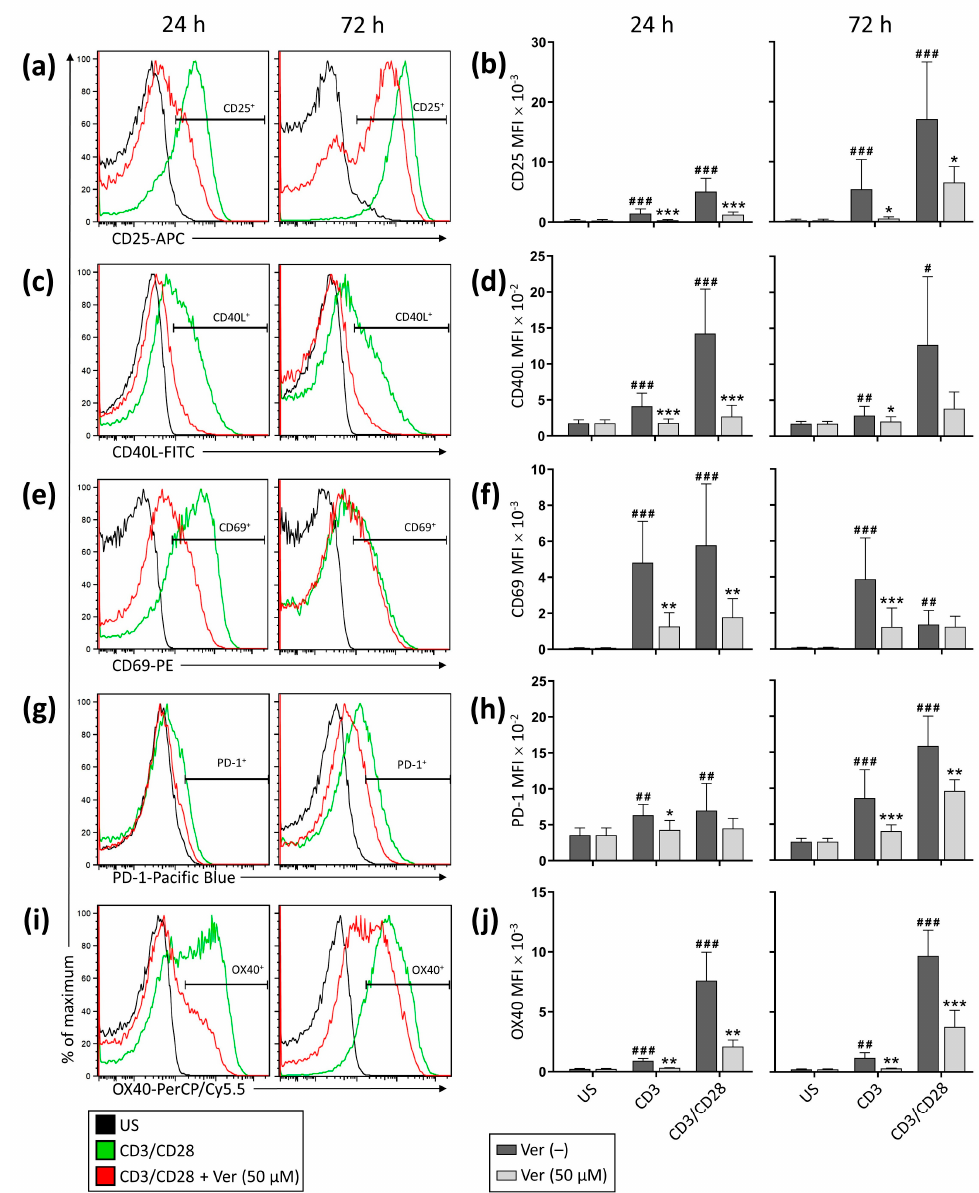
Figure 2. Verapamil decreases the expression of T cell activation-induced cell surface molecules. Purified T cells were stimulated (CD3 alone or CD3/CD28) in the absence or presence of verapamil (50 µ M). Cells were stained for ( a ) CD25, ( c ) CD40L, ( e ) CD69, ( g ) PD-1, and ( i ) OX40 after 24 and 72 h of culture. A histogram of a representative donor for each activation-induced cell surface molecule is shown. ( b , d , f , h , j ) Expression level of the activation-induced cell surface molecules is expressed as MFI. Data from 4–12 donors are shown as mean + SD. The significance of the pairwise comparisons between unstimulated and stimulated (CD3 alone or CD3/CD28) cells is indicated with hash signs ( # p < 0.05, ## p < 0.01, ### p < 0.001). The significance of the pairwise comparisons between cells cultured without and with verapamil is indicated with asterisks (* p < 0.05, ** p < 0.01, *** p <